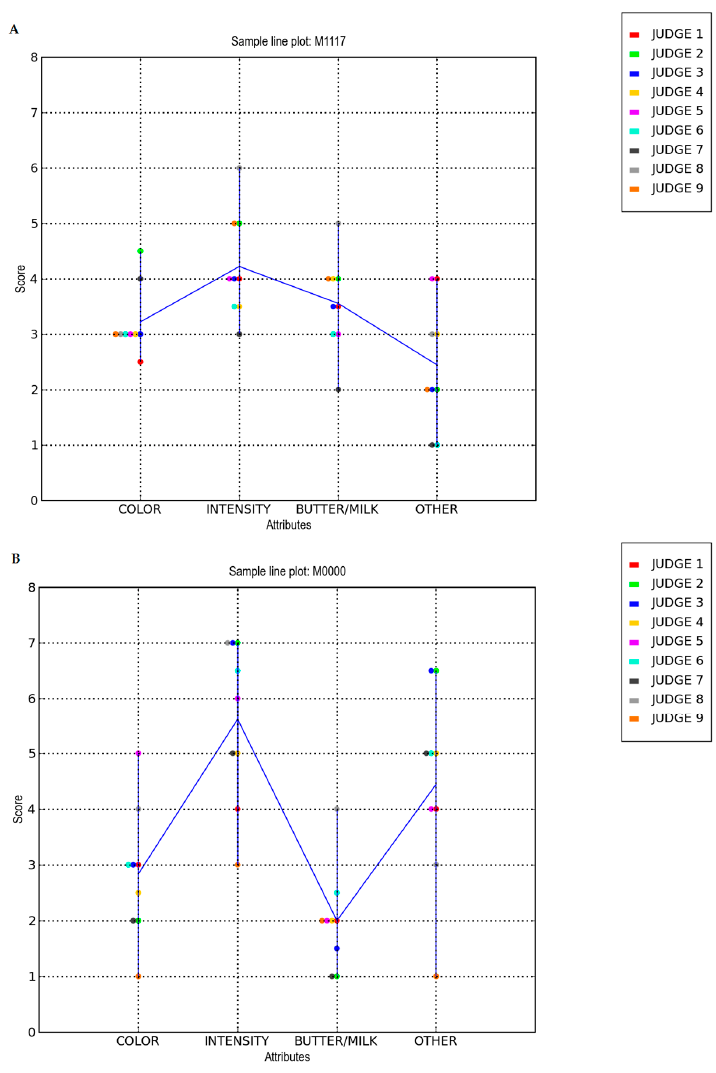
Figure 3. Sample line plots from the descriptive sensory analysis of ( A ) an undegraded cheese sample and ( B ) a degraded cheese sample. A score from 1 to 7 was given by a group of nine panelists based on their sensory perception of both the cheese samples.